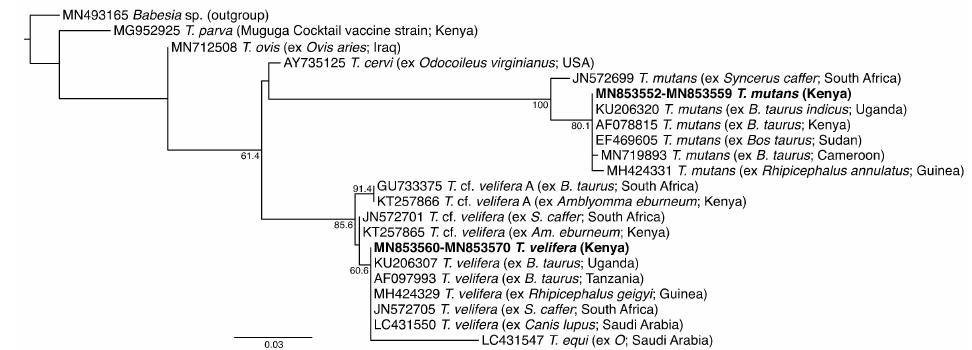
Figure 4. Maximum likelihood phylogeny of 454-bp Theileria 18S rRNA sequences from cattle blood samples. GenBank accession numbers, species, host species, and country of origin are indicated for each reference 18S rRNA gene sequence. Sequences obtained in this study are highlighted in bold and countries of origin are indicated in brackets. The tree is rooted using the Babesia sp. sequence as an outgroup. Bootstrap values at the major nodes represent percent agreement among 1000 replicates. The branch-length scale represents substitutions per site.